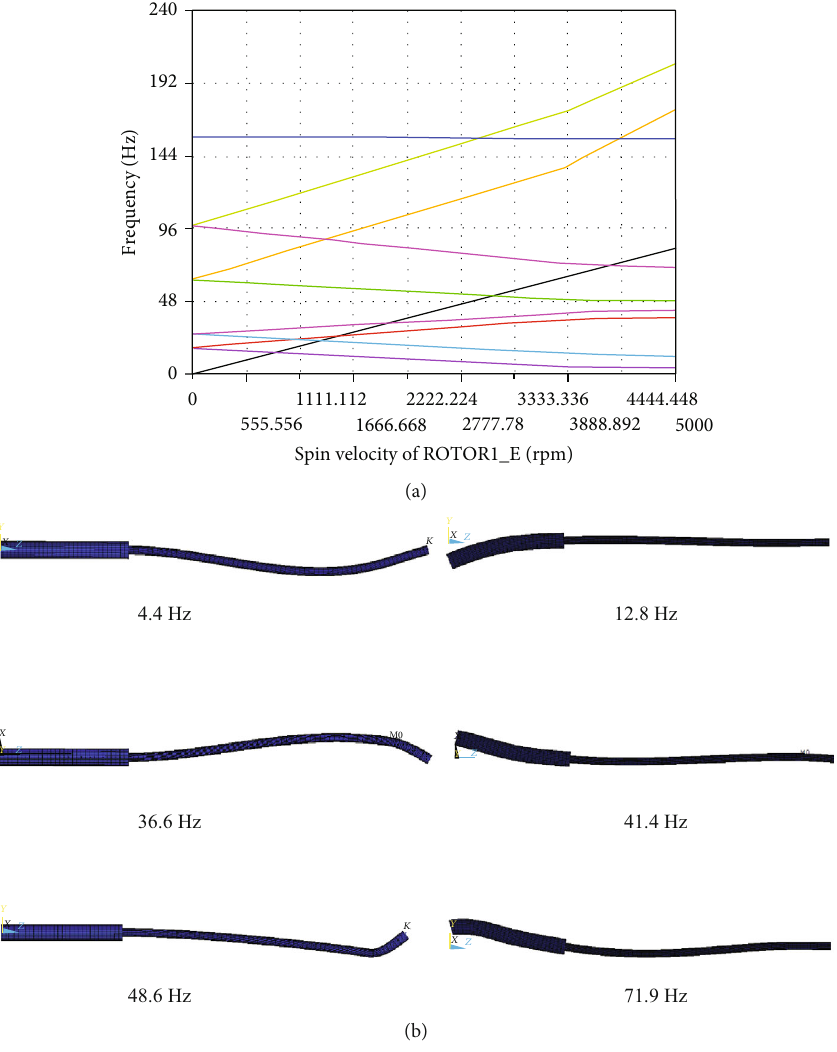
Figure 2: (a) Campbell diagram of a single-rotor system. (b) Mode shape of a single-rotor